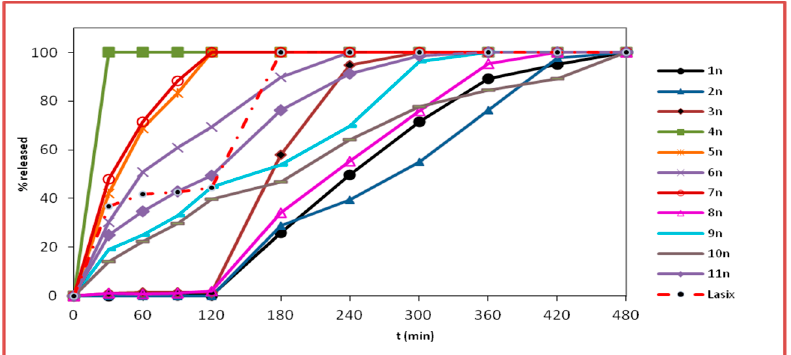
Figure 5. % release (mean values, n = 3) (SD < 2) vs. time (min) of furosemide from the nanofiber tablets (formulations 1n–11n) and the commercially available product (Lasix ® ), at pH 1.2 (0–120 min) and at pH 6.8 (120–300 min).